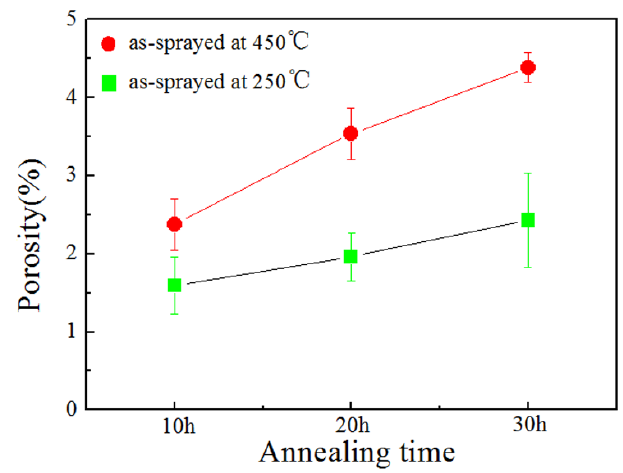
ff erent annealing 2 coatings at di